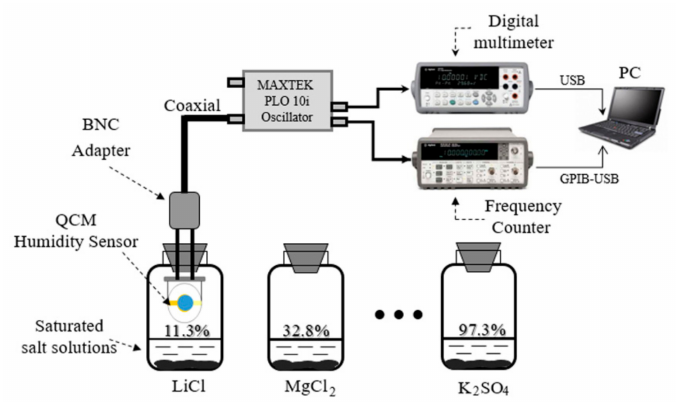
Figure 2. Diagram of a homemade humidity sensing measurement